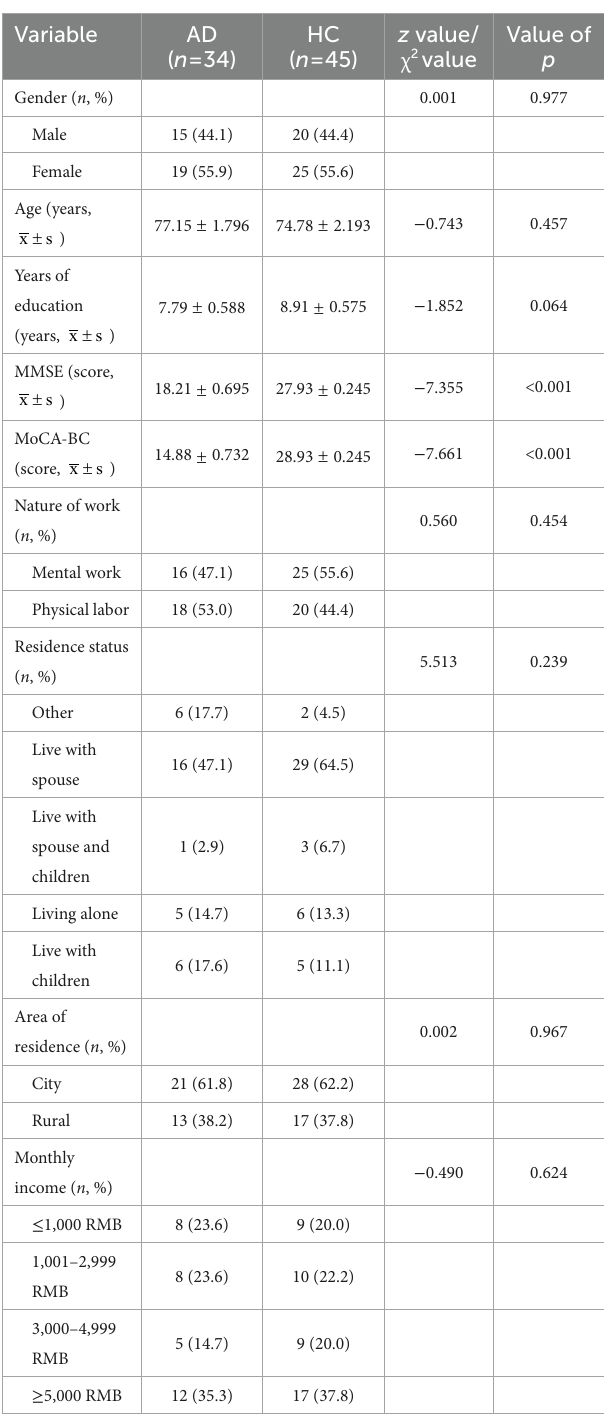
TABLE 1 Comparison of general information of AD patients and the control